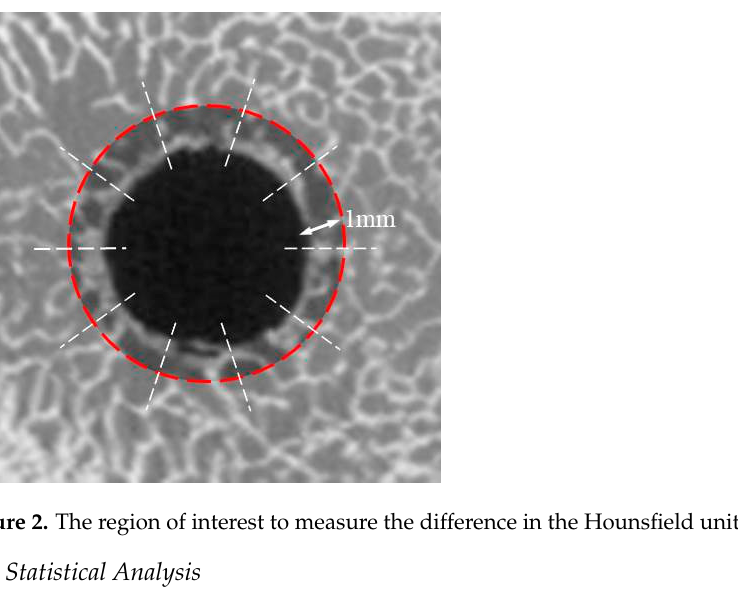
Figure 1. Micro-positron emission tomography/computed tomography images of the sternum: ( A ) total bone; ( B ) trabecular bone.